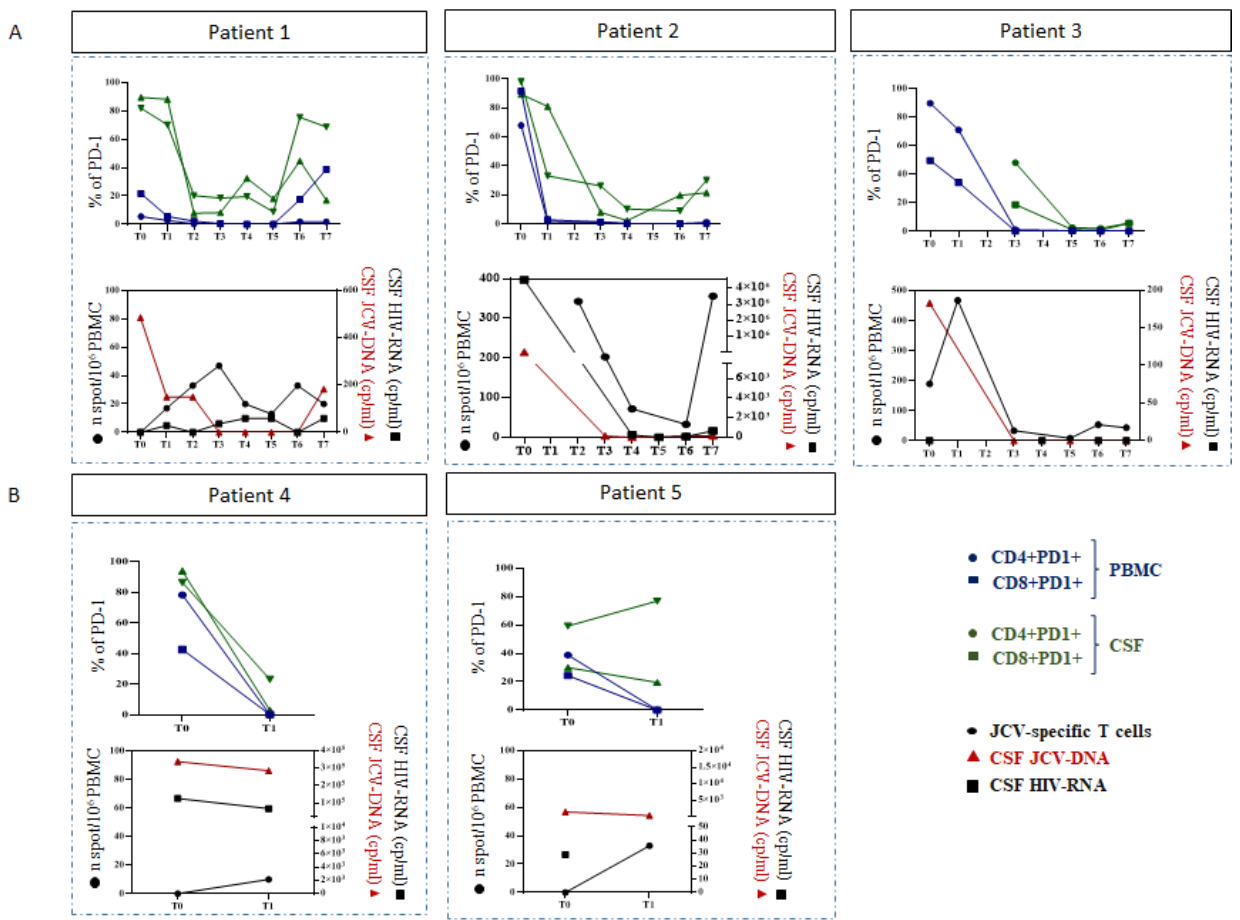
Figure 1. Frequency of circulating and CSF CD4 and CD8 expressing PD-1 was performed by multiparametric flow cytometry; JCV-specific T cell response, JCV-DNA decay and HIV-RNA decay in surviving ( A ) and dead ( B ) patients. JCV-specific T-cell response was performed by Elispot assay; JCV DNA and HIV RNA were tested by Real-Time PCR.